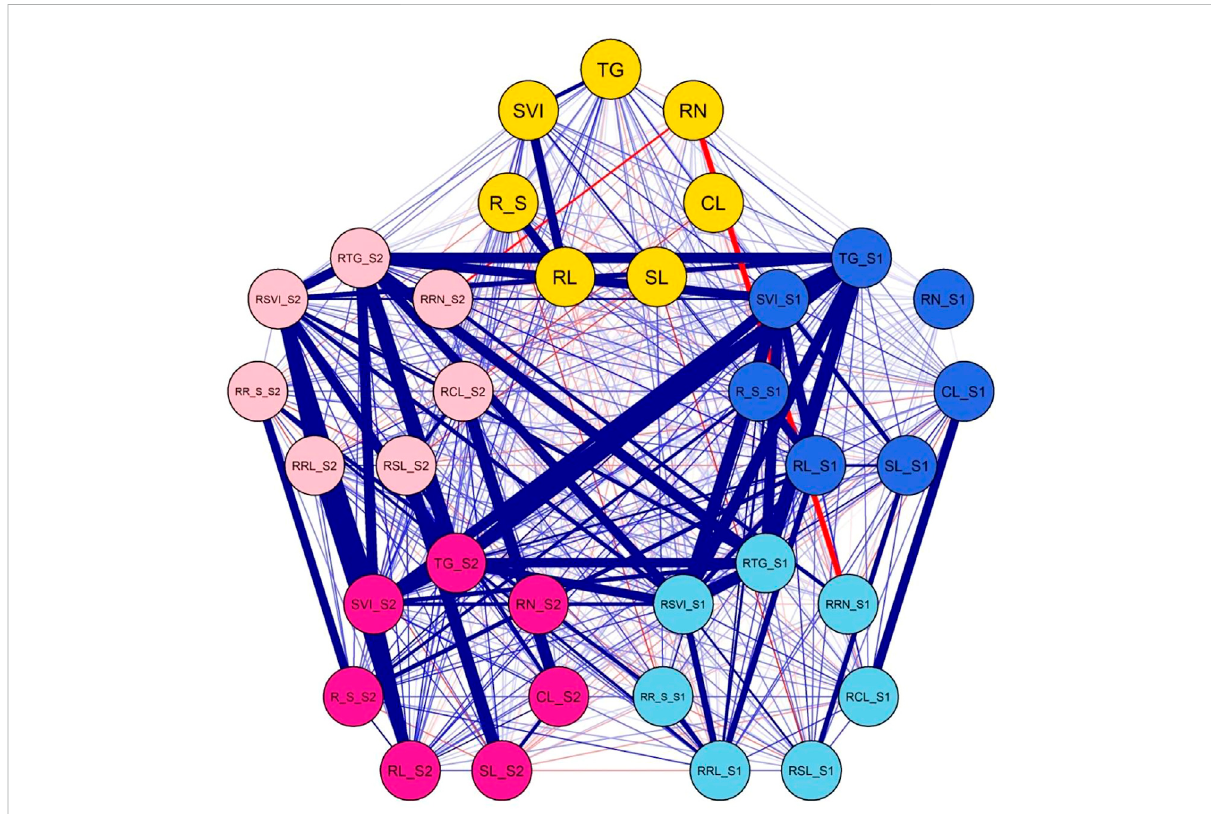
FIGURE 2 Correlations among matrixes of various traits under normal and salt-stress treatments. Yellow circle: traits under control. Blue circle: traits under S1. Sky blue circle: relative traits under S1. Bright pink circle: traits under S2. Light pink circle: relative traits under S2. Thick blue lines: highly signi fi cant correlations. Thin blue lines: signi fi cant correlations. Thick red lines: highly signi fi cant negative correlations. Thin red lines: signi fi cant negative